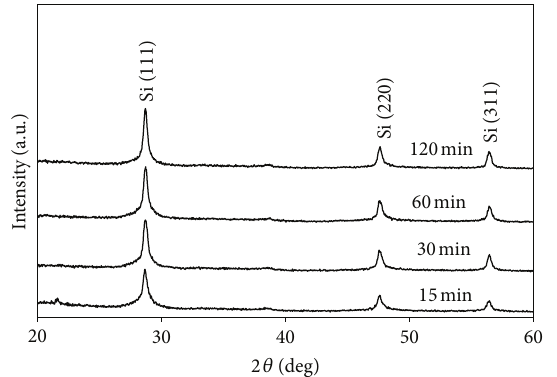
Figure 3: Raman spectra of specimens annealed for various dura-